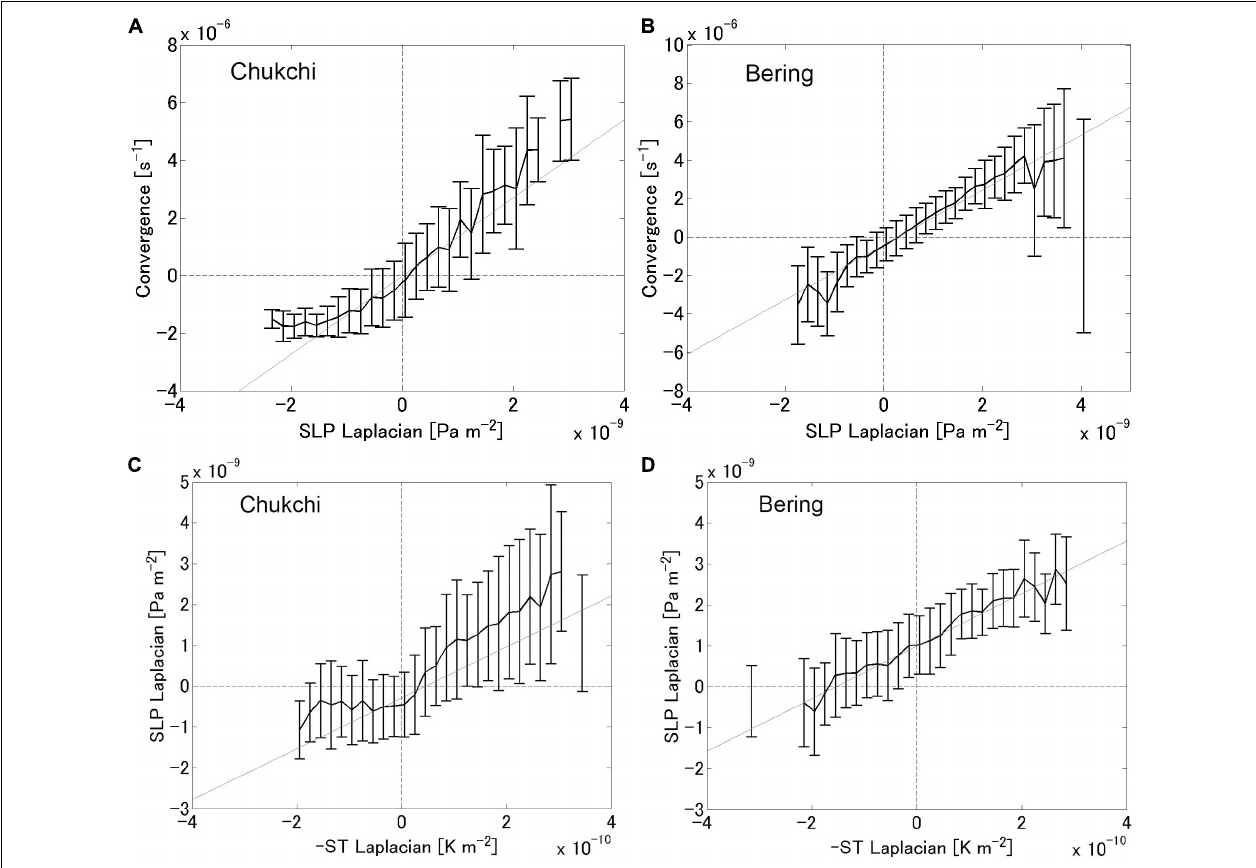
FIGURE 3 | Annual relationships (top) between the SLP Laplacian and surface wind convergence and (bottom) between the SLP and ST Laplacians averaged over the areas defined by the black dashed boxes in Figure 2 in (A,C) the Chukchi Sea and (B,D) the Bering Sea based on monthly climatological data. Gray thin straight line is the linear regression line. Error bars denote ± 1 standard deviation. A two-dimensional median filter of 5 × 5 is applied to the Laplacians of ST and